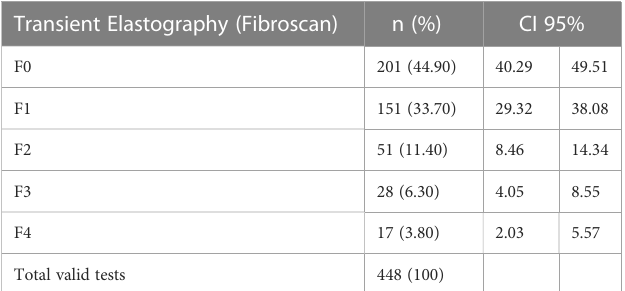
TABLE 2 Results of Transient Elastography.